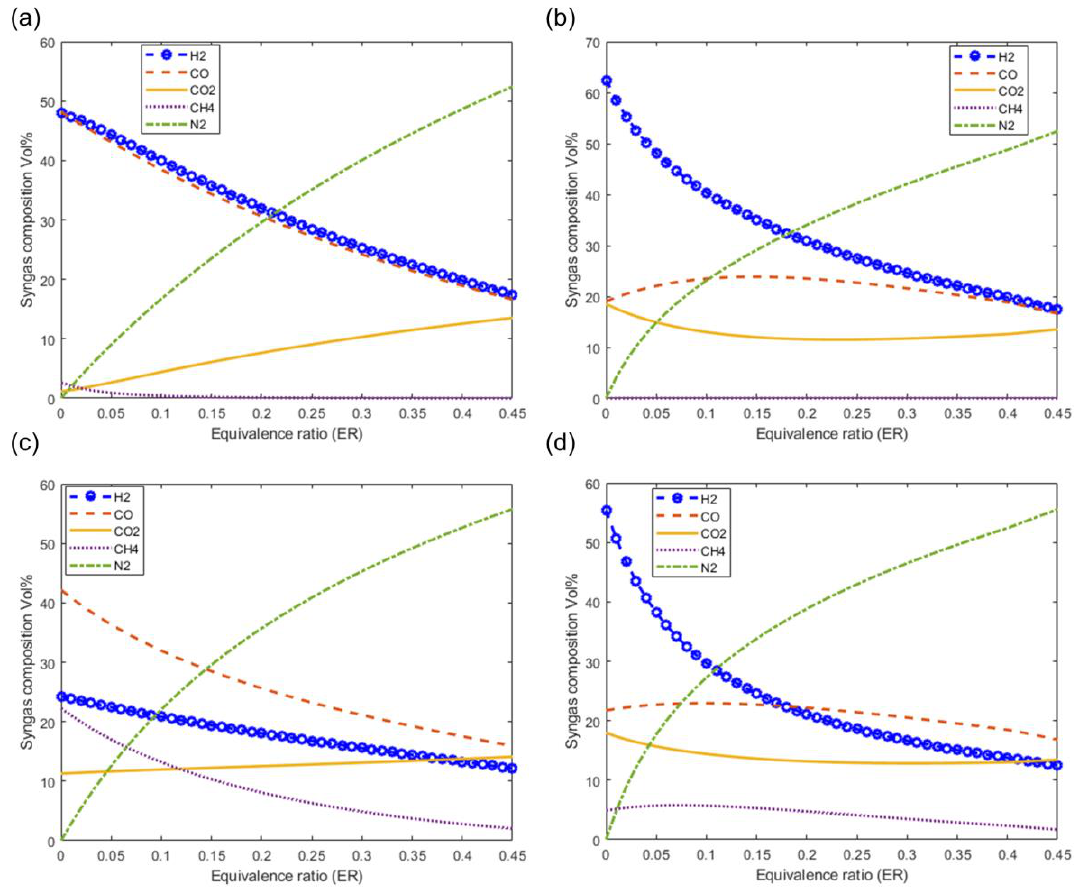
Figure 10. Effect of equivalence ratio on syngas composition at T = 1073, MC = 20%. ( a ) M1, ( b ) M2, ( c ) M3 and ( d ) M4.